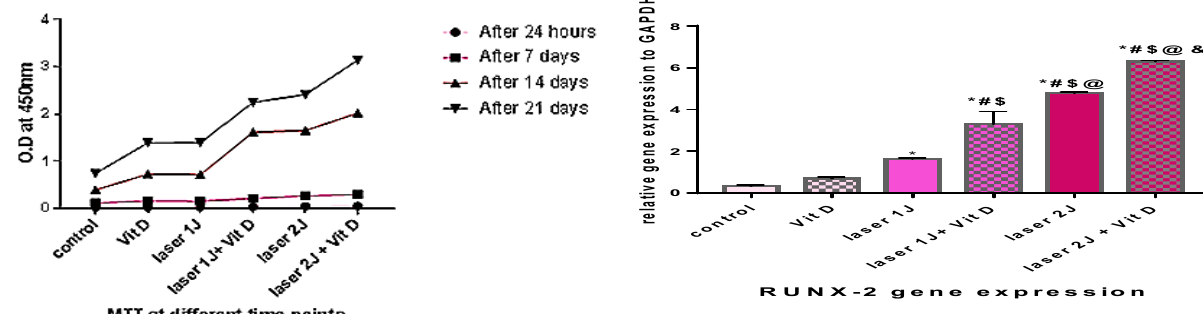
Figure 2: MTT assay measured at 24 h and 7, 14, and 21 days, showing that, at 24 h, there was a statistically significant difference between group VI and the control and vitamin D group (p = 0.008), while, at 21 days, there was a statistically significant difference between the treatment groups and control group (p < 0.0001). Data were expressed as mean ± standard deviation (SD); a P-value <0.05 indicated statistical significance.